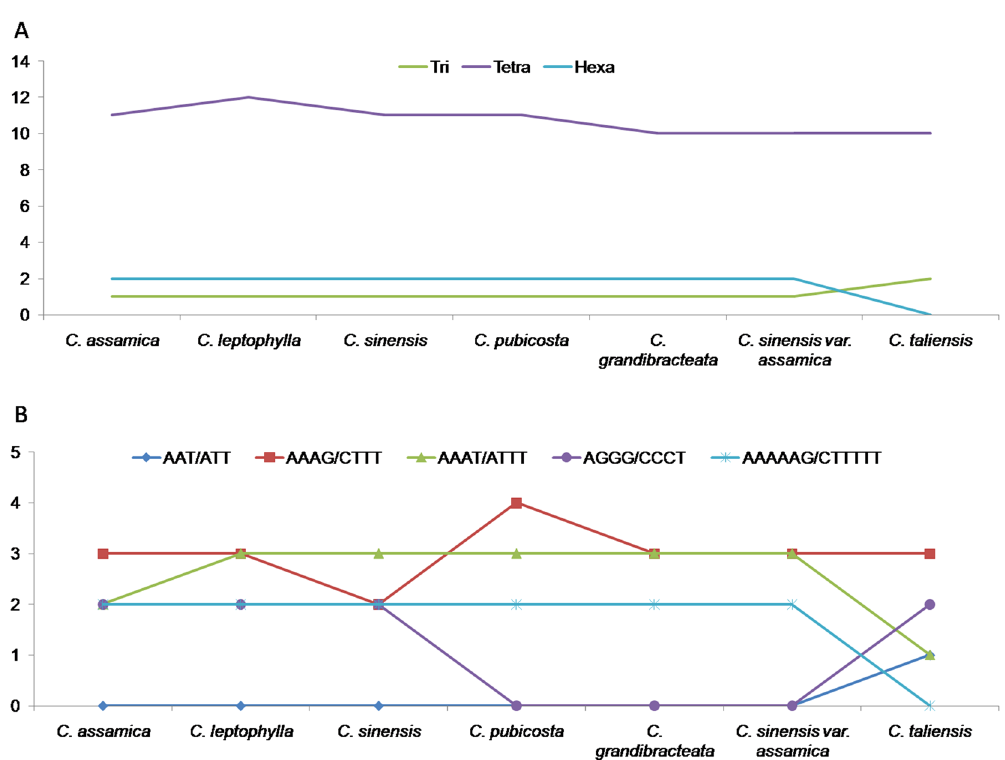
Figure 2. Distribution pattern of tri, tetra and hexa type SSR number ( A ) and SSR motifs ( B ) showing related variation between first three ( C. assamica , C. leptophylla and C. sinensis ), next three ( C. pubicosta, C. grandibracteata and C. sinensis var. assamica ) or last species ( C. taliensis ) under